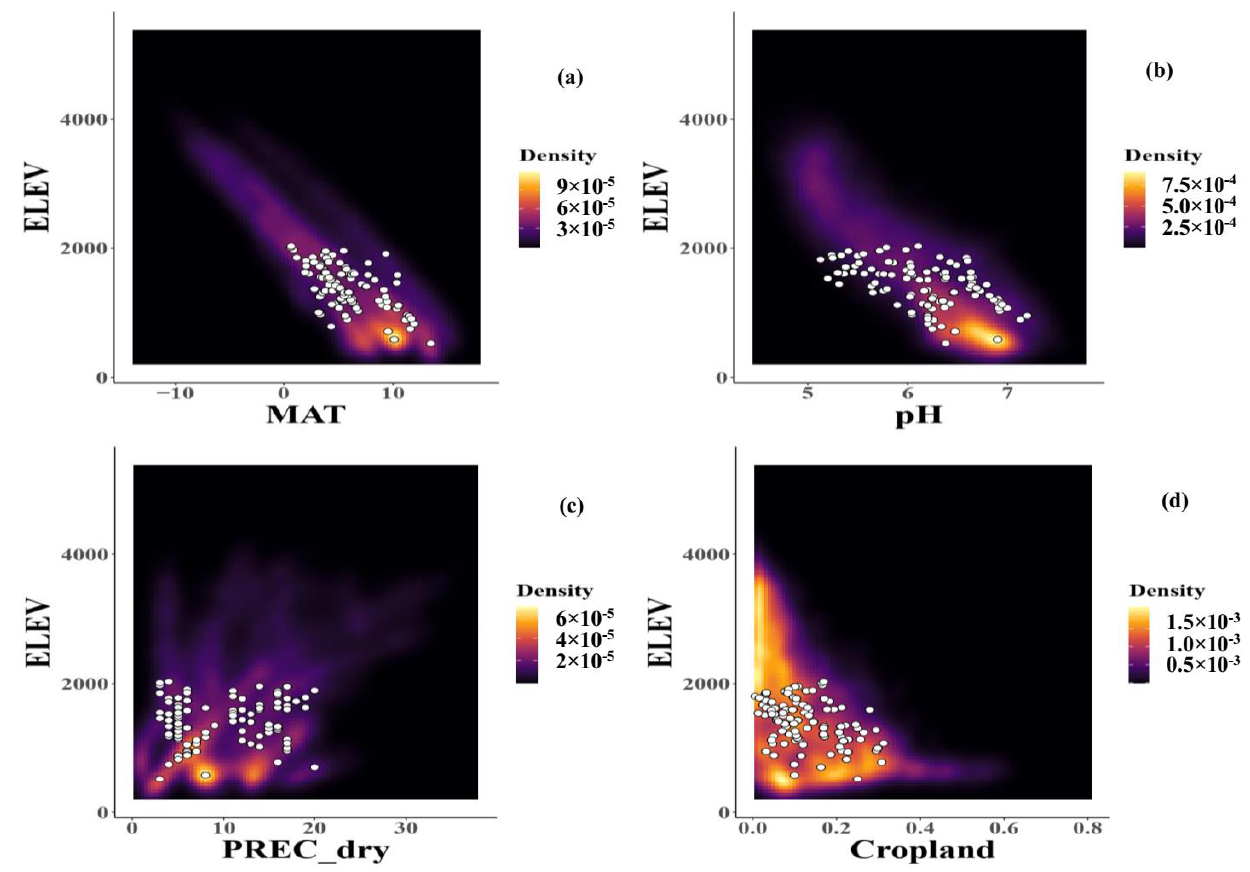
Figure 6. The density distributions of selected environmental predictors for the current occurrence records for wild apple. The white dots represent the occurrence records we used for the ENM. MAT: annual mean temperature; pH: soil pH; PREC_dry: precipitation of driest month. Table 1. The range size and proportion of suitable habitats for wild apple within current protected areas under the current and future